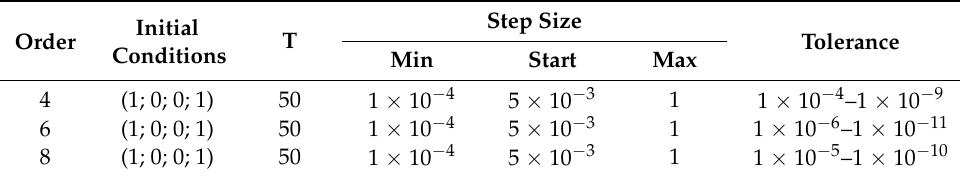
Table 6. Parameter values used in the simulation of two-body problem.